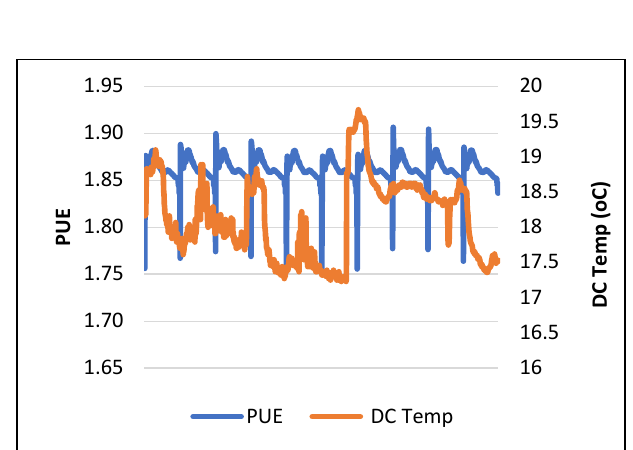
F igure 6. Actual data DC PUE vs temp.